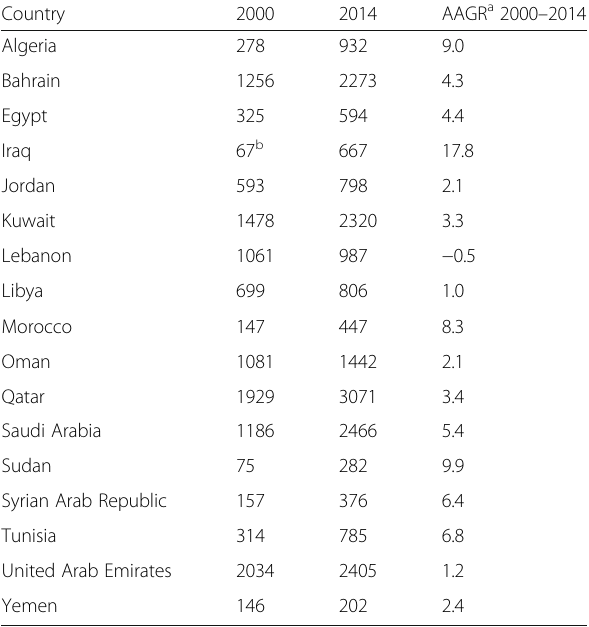
Table 2 Annual per capita total health expenditure by country in International Dollars (purchasing power parity) Country